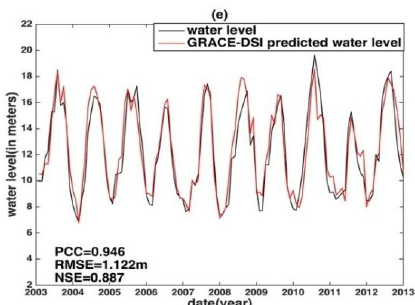
Figure 9. Water level prediction at the location of Hukou station based on various indices including SST anomalies in ( a ) Niño 3.4; ( b ) SOI; ( c ) MEI; ( d ) PDSI; and ( e ) GRACE-DSI.